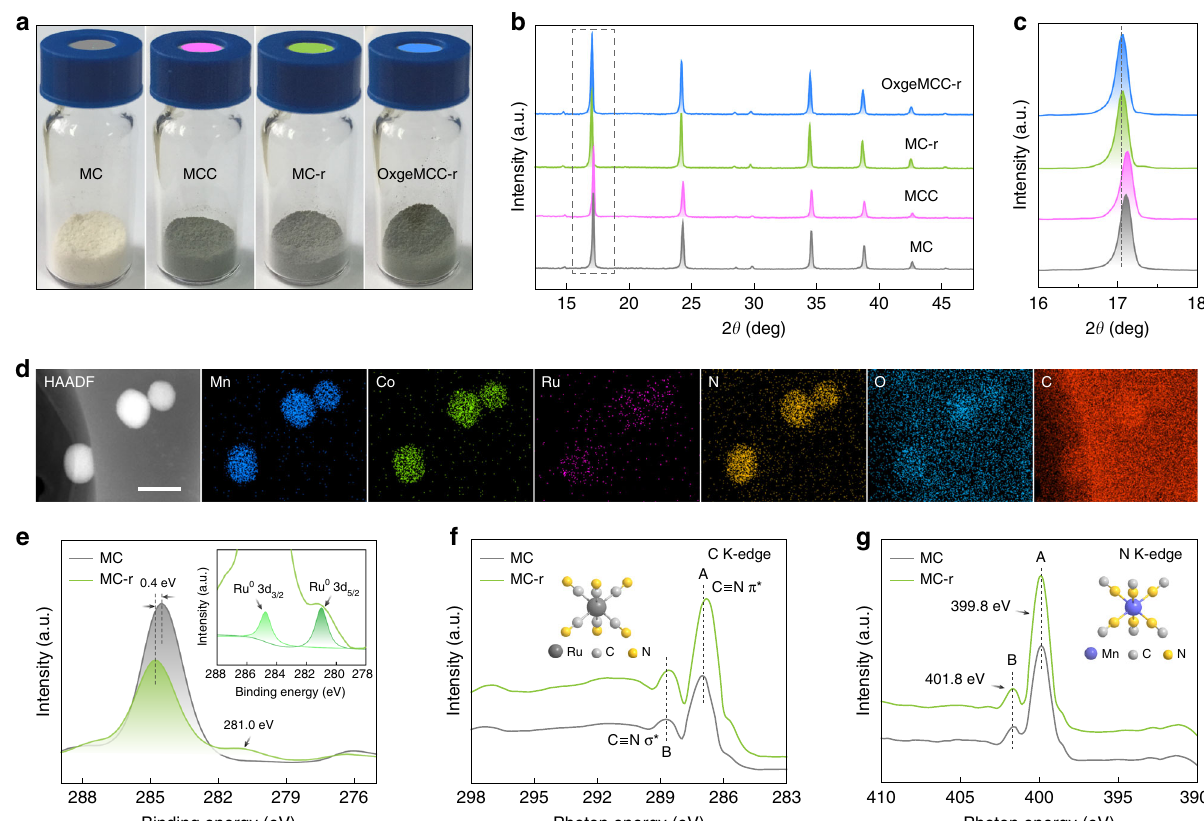
Fig. 3 Structure characterizations. a Photograph of MC, MCC, MC-r, and OxgeMCC-r SAE. b Powder XRD of corresponding materials. c Enlarged powder XRD (2 θ from 16 to 18 degree) of b . d HAADF-STEM image and corresponding EDS elemental mapping (Mn, Co, Ru, N, O, and C elements) of OxgeMCC-r SAEs. Scale bar is 100 nm. e C 1 s XPS spectrum magni fi ed from Supplementary Figs. 1 and 3. Inset is the enlarged Ru 3 d spectrum of MC-r. f C K-edge NEXAFS spectra of MC and MC-r. g N K-edge NEXAFS spectra of MC and